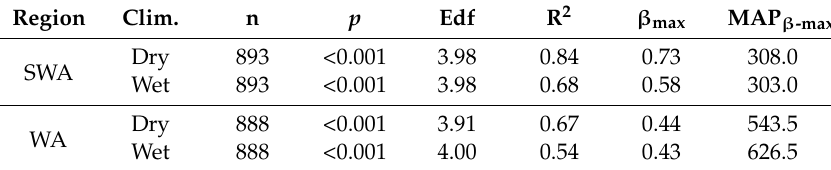
Figure 4. Spatial profiles of vegetation response to rainfall ( β ) as a function of mean annual precipitation (MAP) for the study regions ( a ) South West Africa (SWA) and ( b ) West Africa (WA). Fitted lines represent generalized additive model (GAM) fits. ( c ) Characteristics of peak β values in SWA and WA for a temporal window length of 11 years. Peak values β max and the corresponding mean annual precipitation (MAP β -max ). Colouring represents above and below average rainfall conditions over which data have been aggregated. All data have been averaged over 1 mm MAP steps. Table 1. Model summaries of the fitted generalized additive models (GAMs) with n referring to the number of data points used to fit the models; p indicates the significance level derived from the F-statistics of the fitted smoothing terms; EDF is the estimated degrees of freedom of the respective GAM; R 2 is the variability in β explained by MAP with respect to the fitted GAM. β max corresponds to mean peak β ; MAP β -max is the mean annual precipitation average of the peak position of β